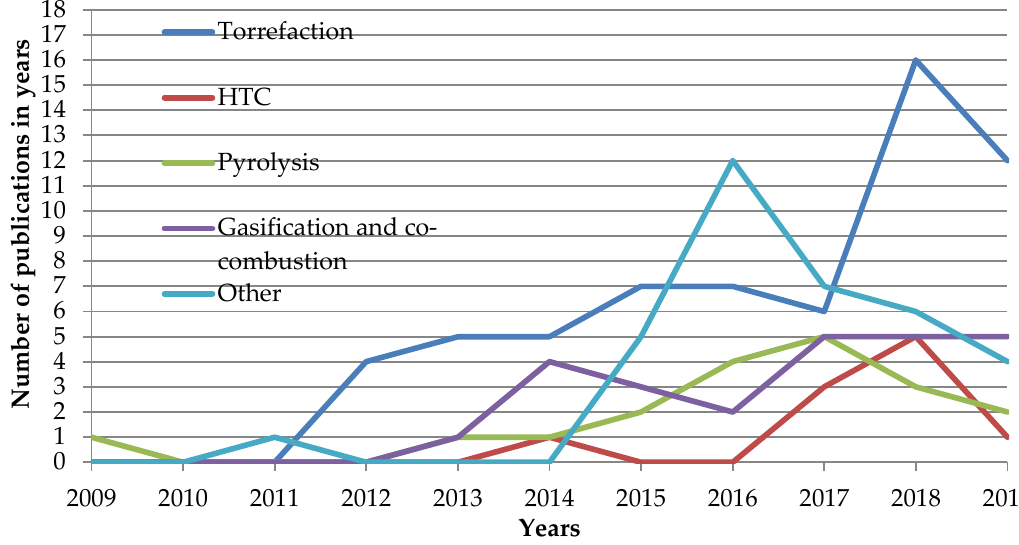
Figure 15. Number of articles in years in individual thematic groups. Publications that did not fit thematically in the groups: torrefaction, HTC, pyrolysis, gasification and co-combustion were placed in the “ other ” group (Figure 14, Appendix A: Table A5). The main topics included regional analysis and global effectiveness of the use of torrefaction and biochar in the bioeconomy, analysis and optimization of the solid biofuels supply chain, analysis of integrated energy generation systems (biomass gasification, gas turbine and others) in selected areas of the economy, product life cycle analysis (LCA), technical and economic analyzes of the biomass torrefaction process in selected countries, optimization of production scheduling, forecasting and modeling of biomass thermal treatment processes, investigation into the applicability of the Bond Work Index (BWI) and Hardgrove Grindability Index (HGI) tests for several biomasses. To date, many review publications have been created covering a selected thematic area (67 documents — WoS-CC, 57 documents — Scopus). These articles are published in leading journals, and their usefulness is demonstrated by a large number of citations. Ex-